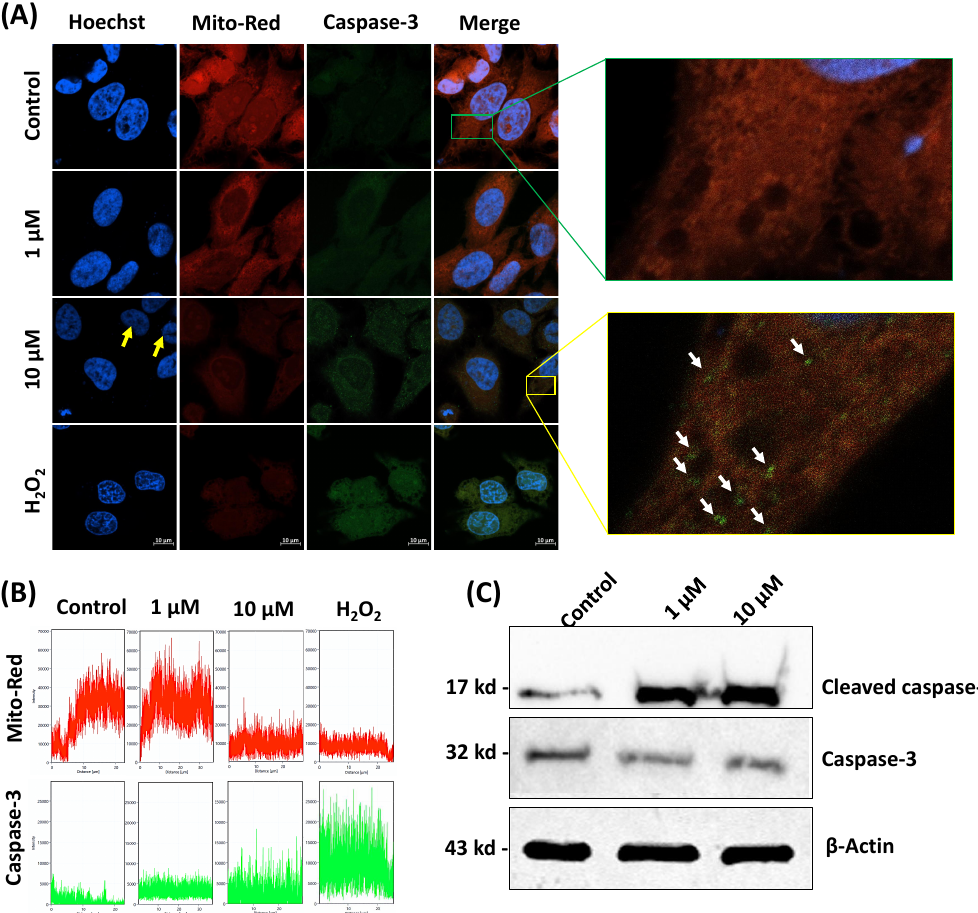
Figure 5. ( A ) Confocal observation of native caspase-3 protein expression (immunofluorescence assay), the integrity of the mitochondrial membrane, and Hoechst 33258 observations of apoptotic nuclei. In Hoechst 33258 stained HeLa cells, the yellow arrow indicates the apoptotic nuclei. Weak nuclear staining in β -cryptoxanthin (10 µ M) treated cells probably caused by condensation and fragmentation of the DNA. The white arrows indicate the enhanced expression of native caspase-3 proteins. ( B ) The red and green fluorescent intensity show the integrity of the mitochondrial membrane and caspase-3 expression, respectively. The x-axis represents the horizontal distance ( µ m) across the cell, and the y-axis represents fluorescence intensity. ( C ) Cleaved caspase-3 protein expression by western blotting analysis. Scale bar, 10 µ